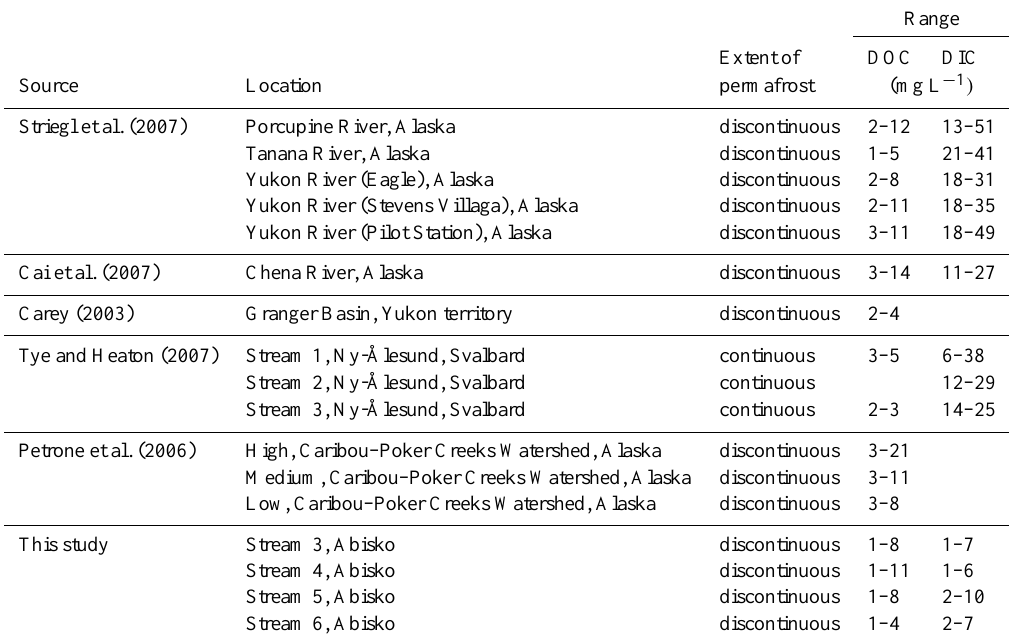
Table 5. Literature data on concentration ranges in permafrost-affected northern streams. The lower DOC value and the higher DIC value reflect base flow conditions whereas the other values are for spring peak flow